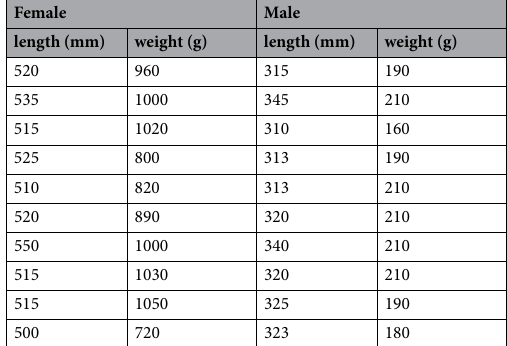
Table 1. The length and weight of female and female